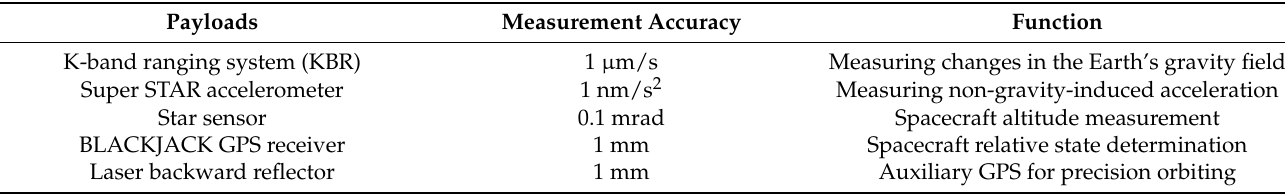
Table 3. Payloads performance of GRACE.